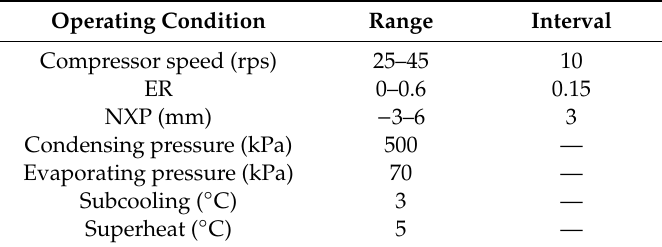
Table 2. Test conditions in the present